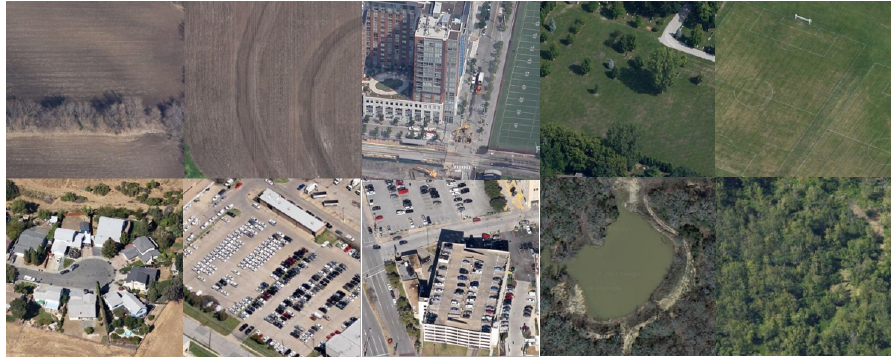
Figure 6. Samples of RSSCN7 dataset.